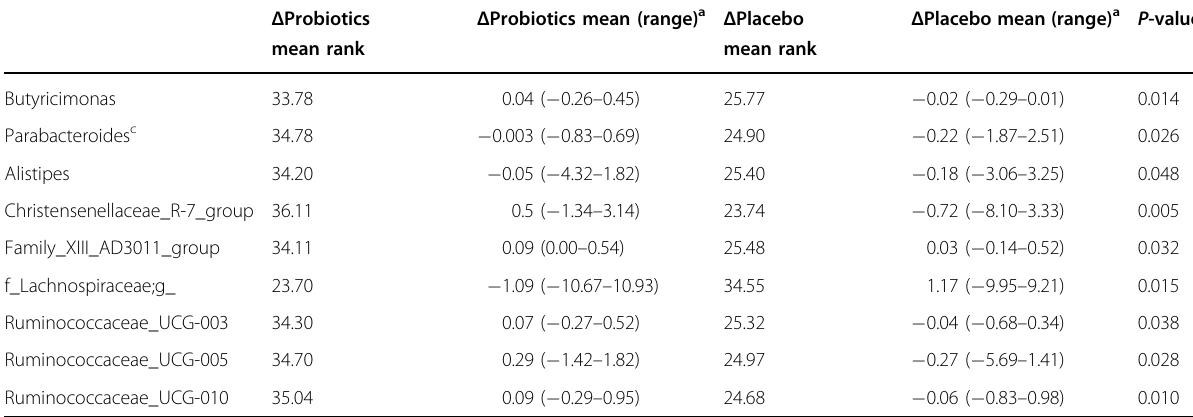
Table 1 Comparison of genus relative abundance post – pre intervention changes ( Δ ) between probiotics and placebo